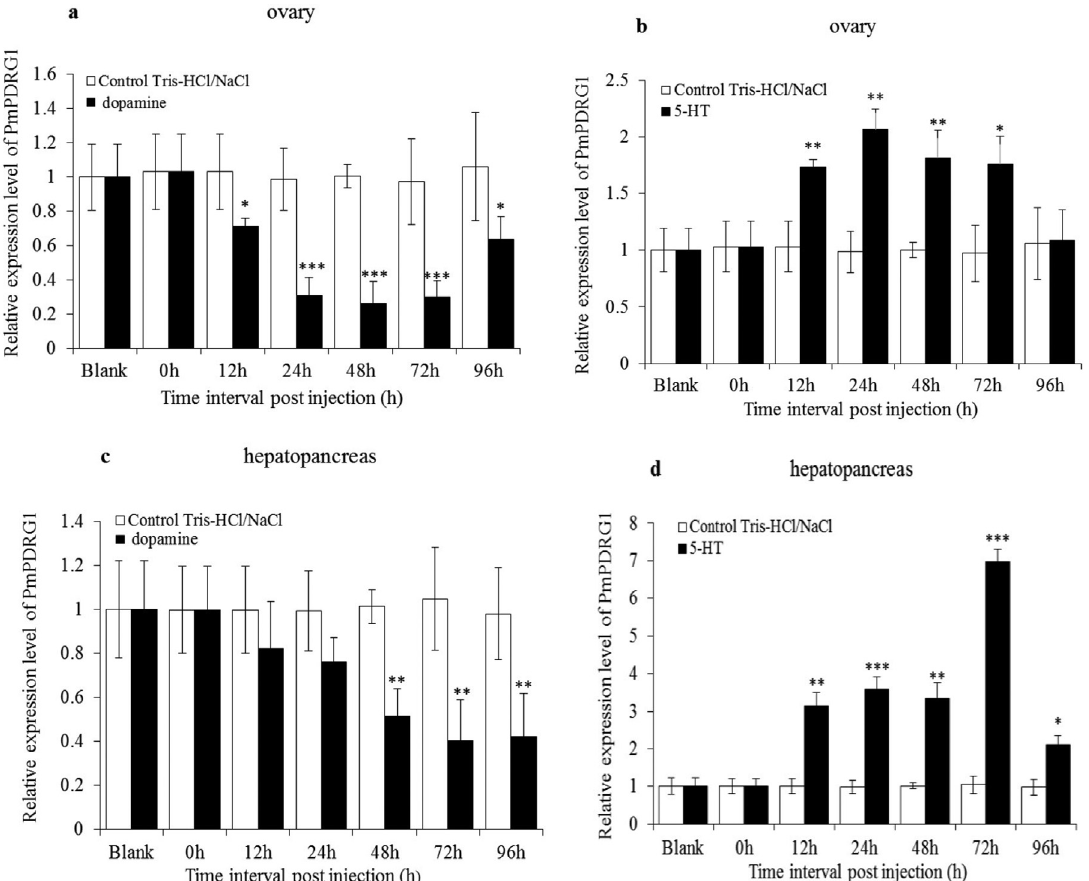
Figure7 - PmPDRG1 mRNAexpressionprofilesafterstimulationwith5-HTandDA.(a) PmPDRG1 relativeexpressionlevelsinovarytissueposttreat- ment with DA. (b) PmPDRG1 relative expression levels in ovary tissue post treatment with 5-HT. (c) PmPDRG1 relative expression level in hepatopancreas tissue post treatment with DA. (d) PmPDRG1 relative expression levels in hepatopancreas tissue post treatment with 5-HT. Vertical bars represent the mean (cid:2) SD (n =3). Significant differences between the experimental and the control group are indicated by asterisks * P < 0.05; ** P < 0.01; *** P <